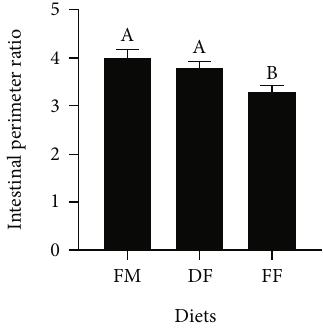
Figure 2: The intestinal perimeter ratio in turbot. The di ff erent letters on the bar chart represent signi fi cant di ff erences in the mean values ( n = 6 ) between the groups ( P < 0 : 05